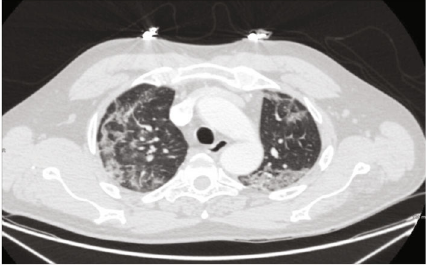
Figure 2: Axial contrast-enhanced chest CT in lung window showing bilateral peripheral ground-glass opacities.